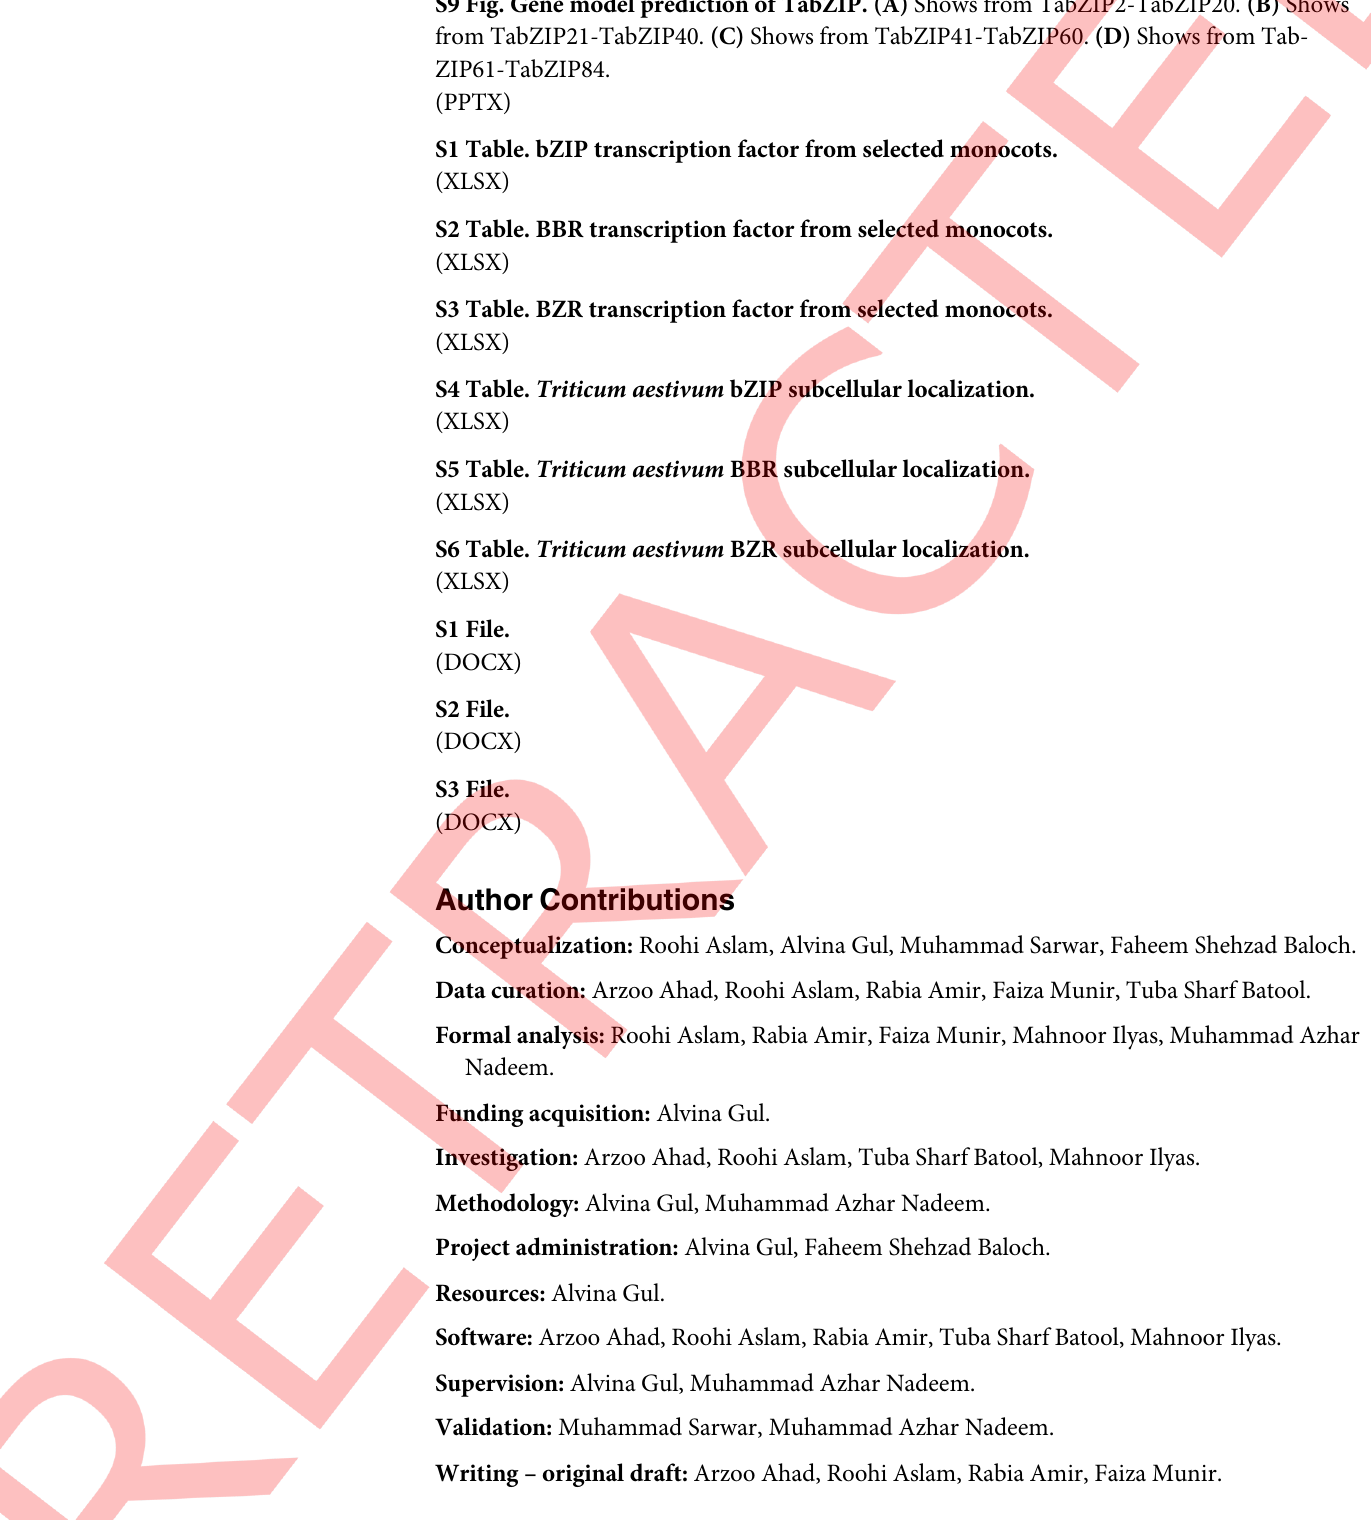
S8 Fig. Subcellular localization of TaBZR Proteins. S9 Fig. Gene model prediction of TabZIP. (A) Shows from TabZIP2-TabZIP20. (B) Shows from TabZIP21-TabZIP40. (C) Shows from TabZIP41-TabZIP60. (D) Shows from Tab-